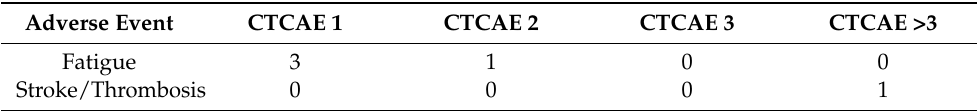
Table 3. Adverse events after robotic radiosurgery (within 6 weeks). Adverse Event CTCAE 1